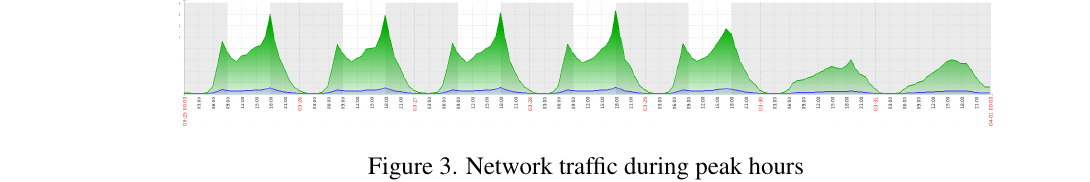
Figure 3. Network traffic during peak hours